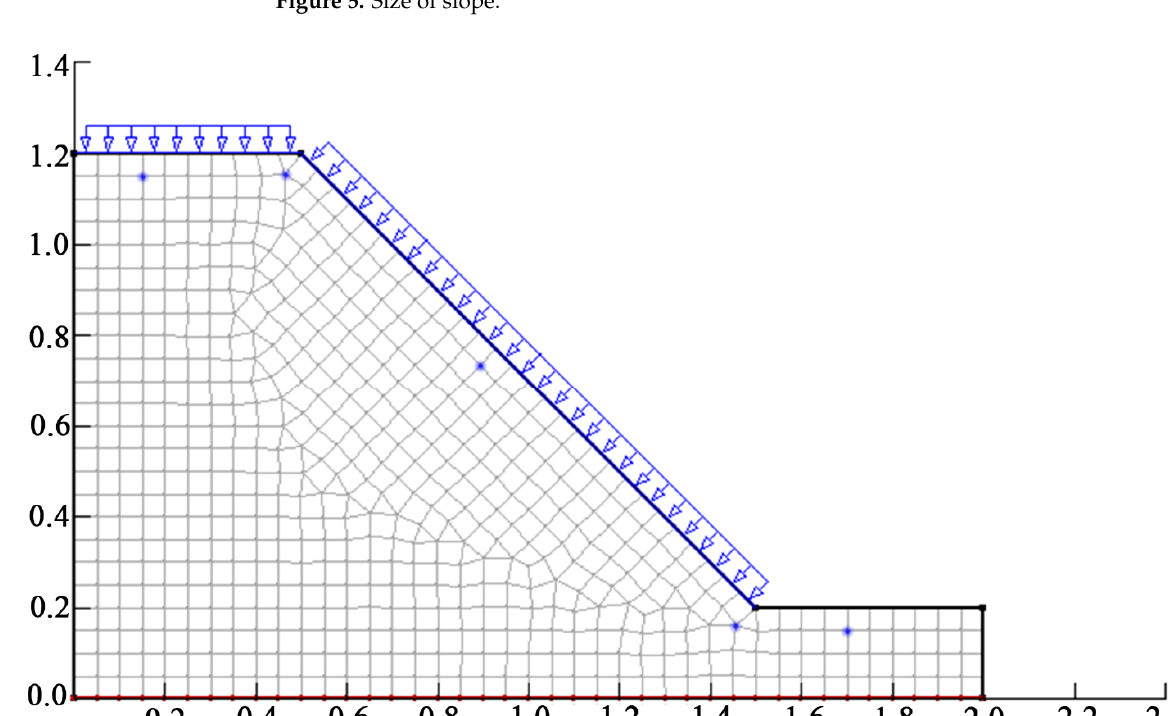
Figure 5. Size of slope.